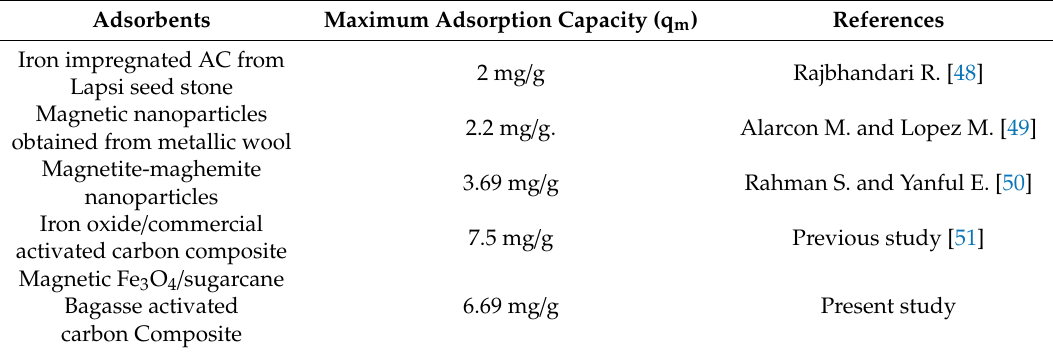
Table 2. Langmuir and Freundlich parameters for the adsorption of As (III) onto the composite. Adsorbents